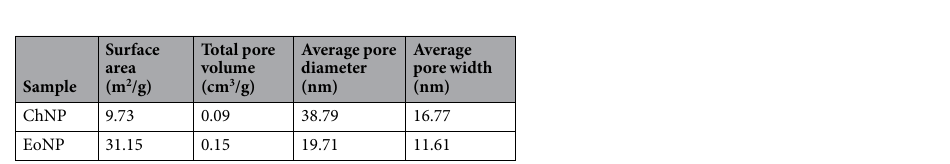
Table 1. The surface characteristics analysis on ChNP and EoNP based on BET analysis. - = no inhibition zone.